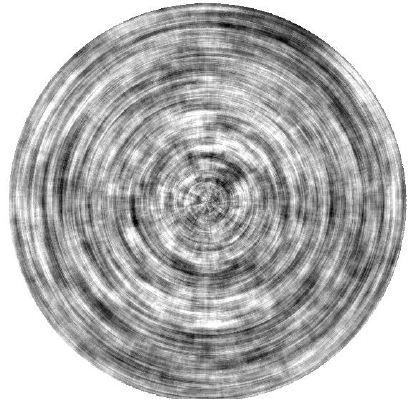
Figure 8. The image with circular correlation